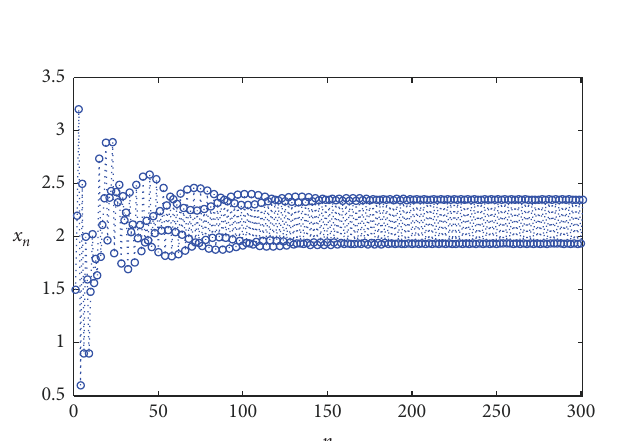
Table 1 and Figure 1 refect that the nonnegative solution of equation (25) converges to a 6-periodic solution of equation (25).